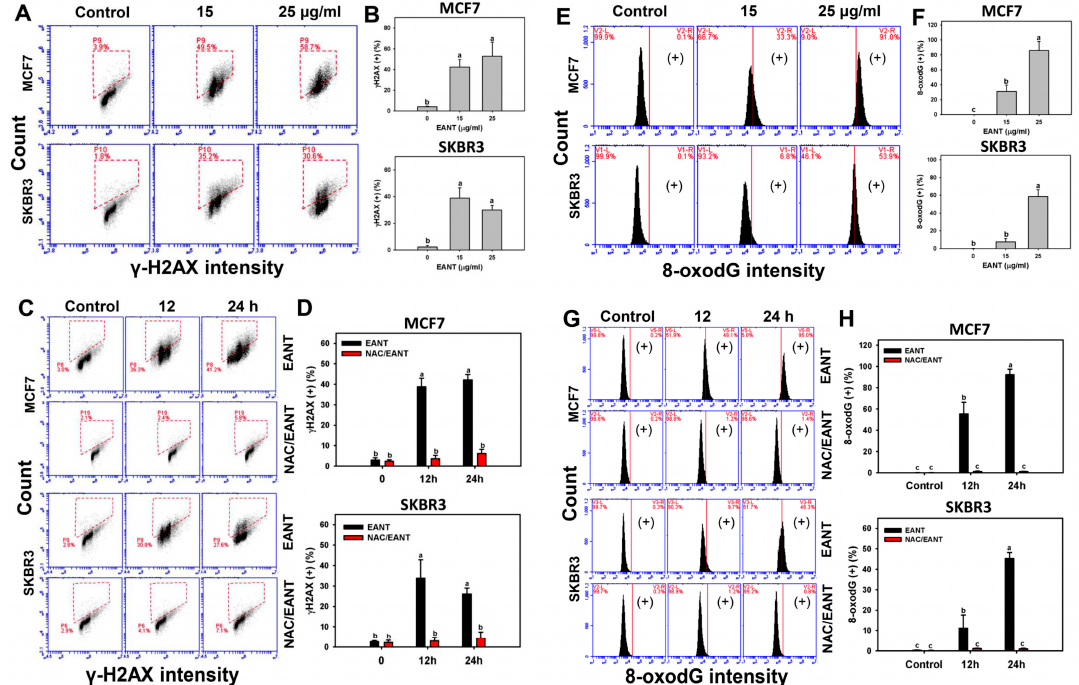
Figure 6. γ H2AX and 8-oxodG changes after EANT treatment. ( A , B ) The concentration e ff ect of EANT on γ H2AX patterns and statistics. Breast cancer cells (MCF7 and SKBR3) were treated with 0 (control with DMSO only), 15, and 25 µ g / mL of EANT for 24 h. The dashed box indicates the γ H2AX ( + ) population. ( C , D ) Time course e ff ect of EANT on γ H2AX patterns and statistics. Without or with NAC pretreatment, breast cancer cells (MCF7 and SKBR3) were treated with 25 µ g / mL of EANT for 0 (control with DMSO only), 12 and 24 h. ( E , F ) The concentration e ff ect of EANT on 8-oxodG patterns and statistics. Breast cancer cells (MCF7 and SKBR3) were treated with control with DMSO only and EANT for 24 h. ( G , H ) Time course e ff ect of EANT on 8-oxodG patterns and statistics. Without or with NAC pretreatment, breast cancer cells (MCF7 and SKBR3) were treated with 25 µ g / mL of EANT for 0 (control with DMSO only), 12, and 24 h. For each cell line, treatments labeled without the same lower-case letters indicate significant di ff erence. p < 0.01~0.001. Data, mean ± SD (n = 3). ( + ) indicates the 8-oxodG ( + ) population. Positive controls for γ H2AX and 8-oxodG were provided in Supplementary Figure